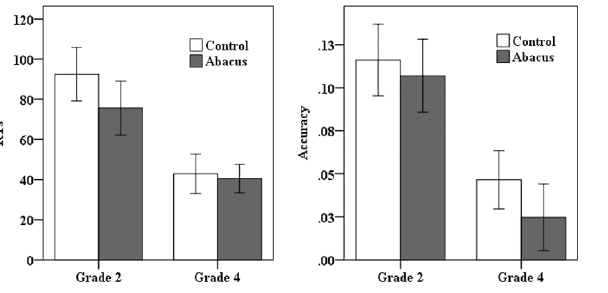
Fig 2. Switch cost measured by mean RT and accuracy for the two groups across grades. The error bars represented one standard error of the mean.